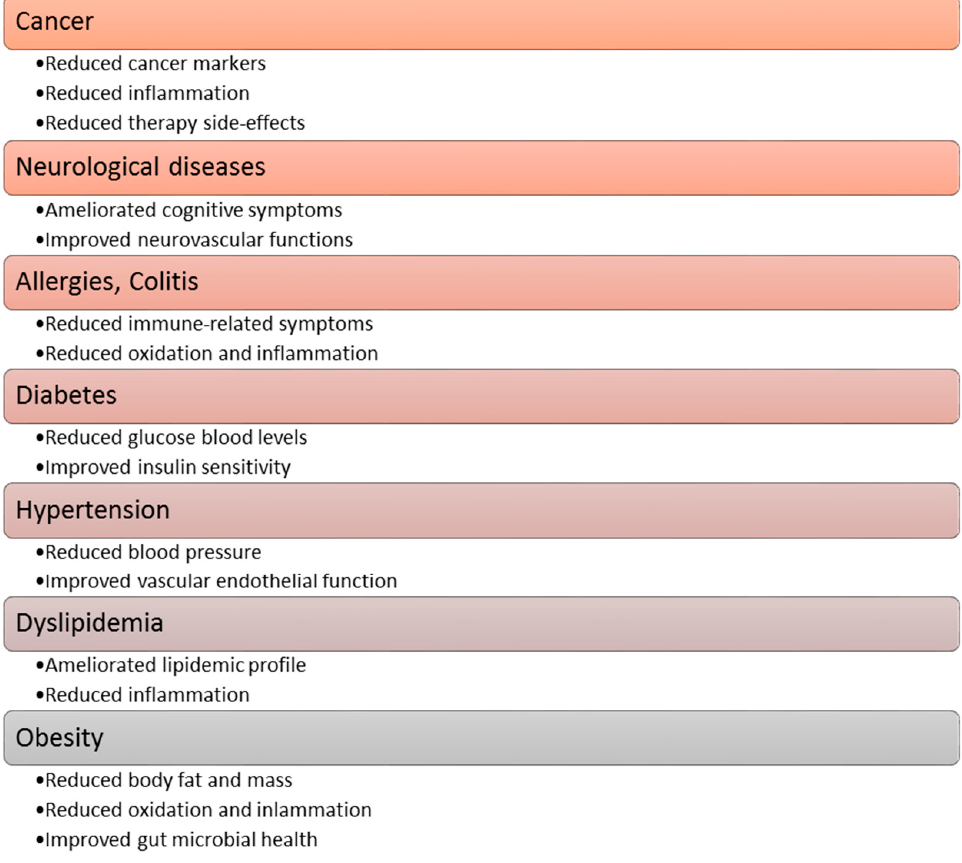
Figure 4. The effect of polyphenolic compounds on selected diseases. The potential of dietary polyphenols to produce therapeutic effects can be at least partly attributed to the bi-directional link with the gut microbiome. This is due to the fact that polyphenolic compounds affect the composition of the intestinal microbiome in a way that leads to the preservation of homeostasis in the human body. In particular, the gut microbiome converts polyphenols into bioactive compounds that have therapeutic effects [36]. 4. Polyphenolic Compounds as a Considerable Plant Component of the Daily Diet Polyphenolic compounds are commonly found in plant foods (for example, vegeta- bles, red fruits and grapes) and plant-based beverages (wine, green tea coffee) [51]. The content of these compounds varies, even when comparing varieties of the same species. For example, the formation of flavonol glycosides and flavonol glycosides depends on the access of light, and for this reason, their highest concentrations are in the leaves and outer parts of plants. In contrast, only small amounts are recorded in parts of plants that are underground [52]. Moreover, the sensory and nutritional properties of plant foods de- pend on the content of polyphenols [35]. Free phenolic acids are found mainly in vegeta- bles and fruits [53]. In contrast, cereal products are mostly characterised by the presence of bound phenolic acids [54]. Table 1 provides information on the main dietary sources of the most important ex- amples of polyphenolic compounds.